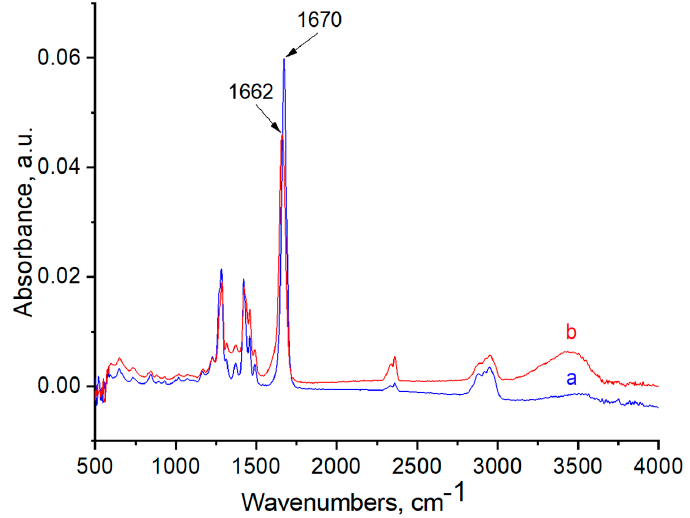
Figure 6. FTIR spectra of PVP 40 kDa ( a ) and PVP-AuNPs ( b ).